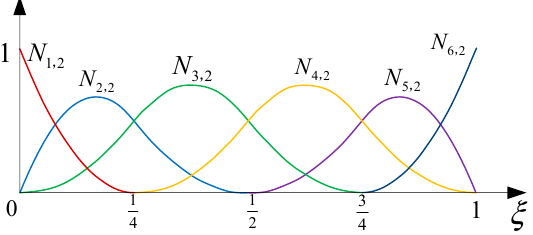
Figure 5. Quadratic univariate B-spline basis functions ( q = 2) defined over the uniform and open knot (cid:110) (cid:111) vector H = 0,0,0, 1 , 1 , 3 ,1,1,1 2 1 4